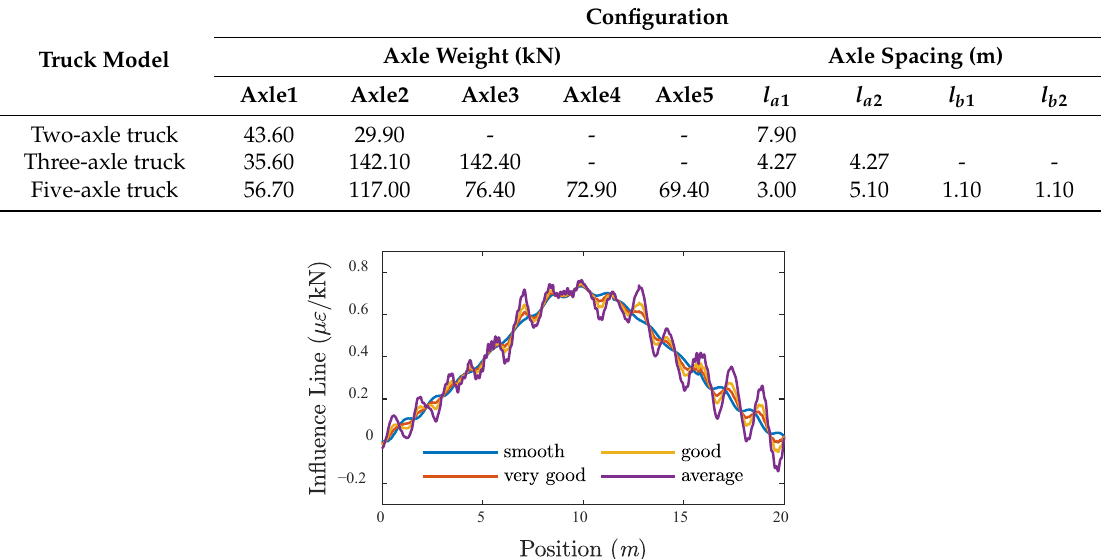
Table 2. Configuration of calibration truck models.